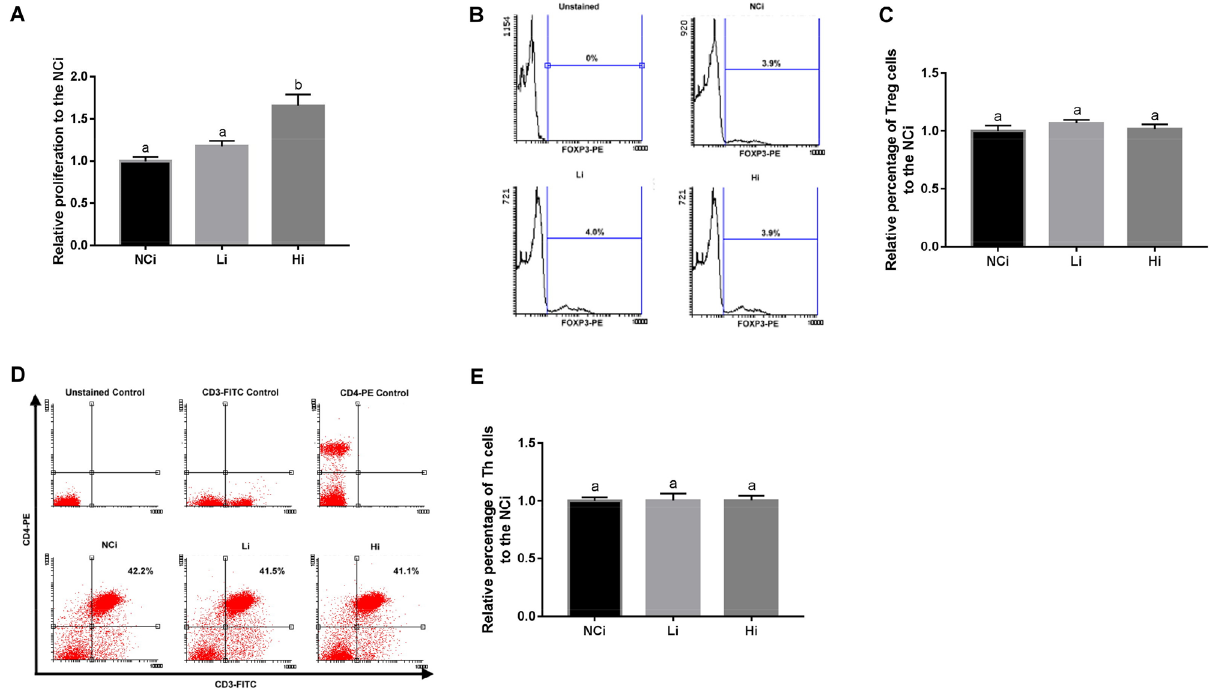
Figure 1. Effects of LcSFB on splenocytes from OVA-injected (s.c.) mice ex vivo. ( A ) Splenocyte proliferation. ( B ) Representative experiments evaluating the effect of LcSFB on Treg cells. ( C ) Relative percentages of